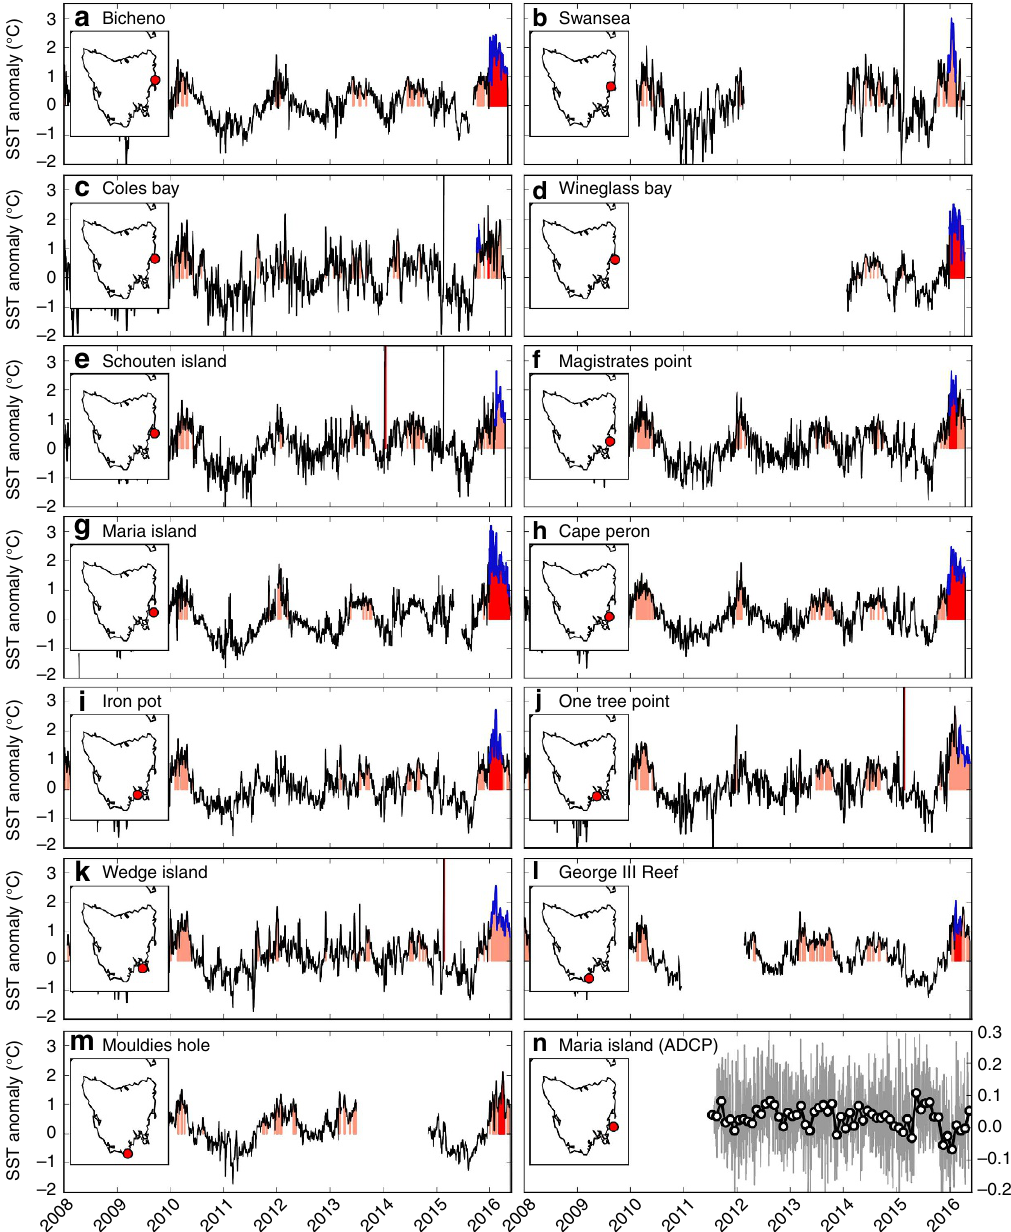
Figure 2 | Near-shore temperature and velocity records around Tasmania. ( a – m ) Temperature anomalies are shown for 13 sites along Tasmania’s eastern shelf. The shaded regions indicate each MHW detected using the Hobday et al. 2 definition, the red-shaded region is the largest event (by maximum intensity) and the blue line indicates the longest event. ( n ) Depth-averaged meridional velocity measured with an Acoustic Doppler current profiler (ADCP) at the Maria Island Australian National Mooring location (daily means as grey line, monthly means as open